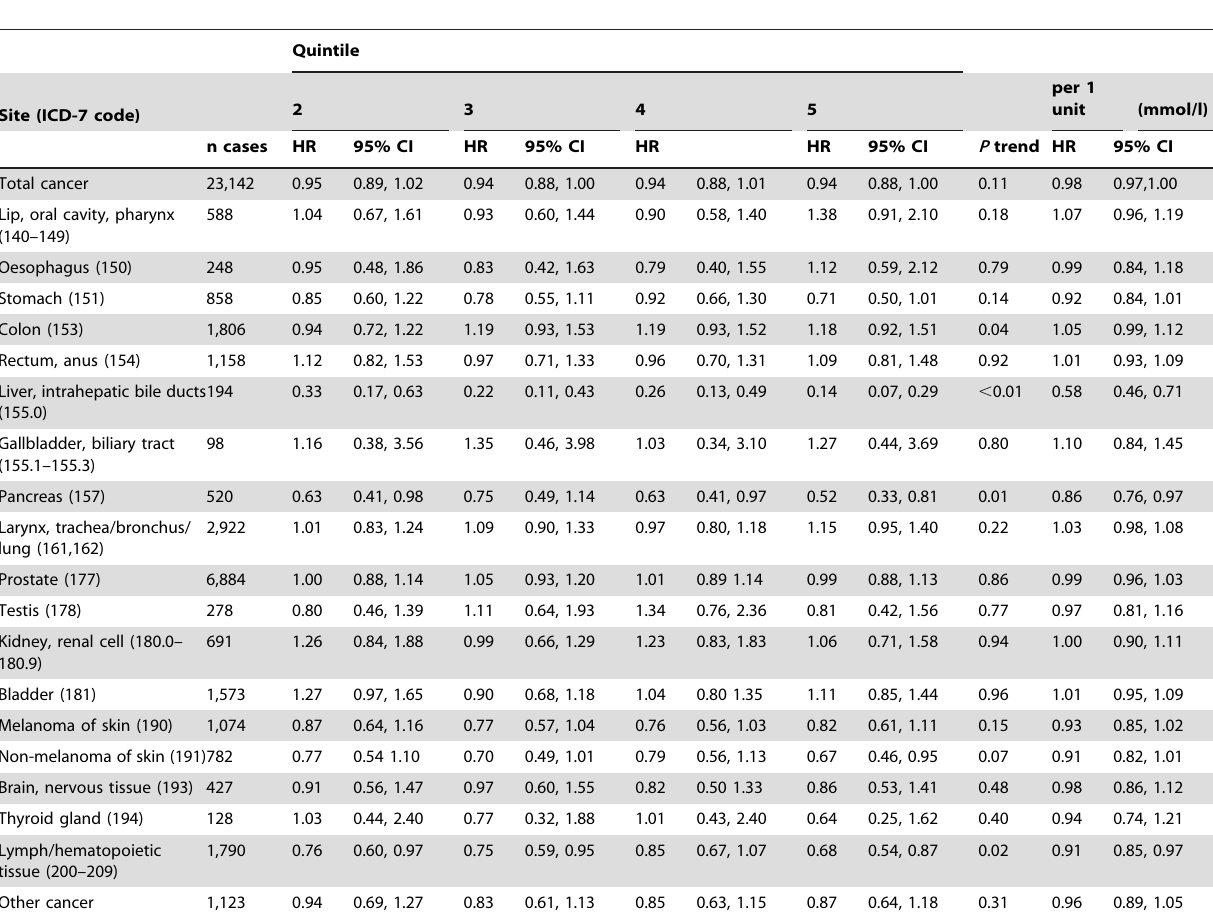
Table 2. RDR corrected hazard ratios a of incident cancer by cholesterol in quintiles (compared to the lowest quintile) and per unit increment in men.